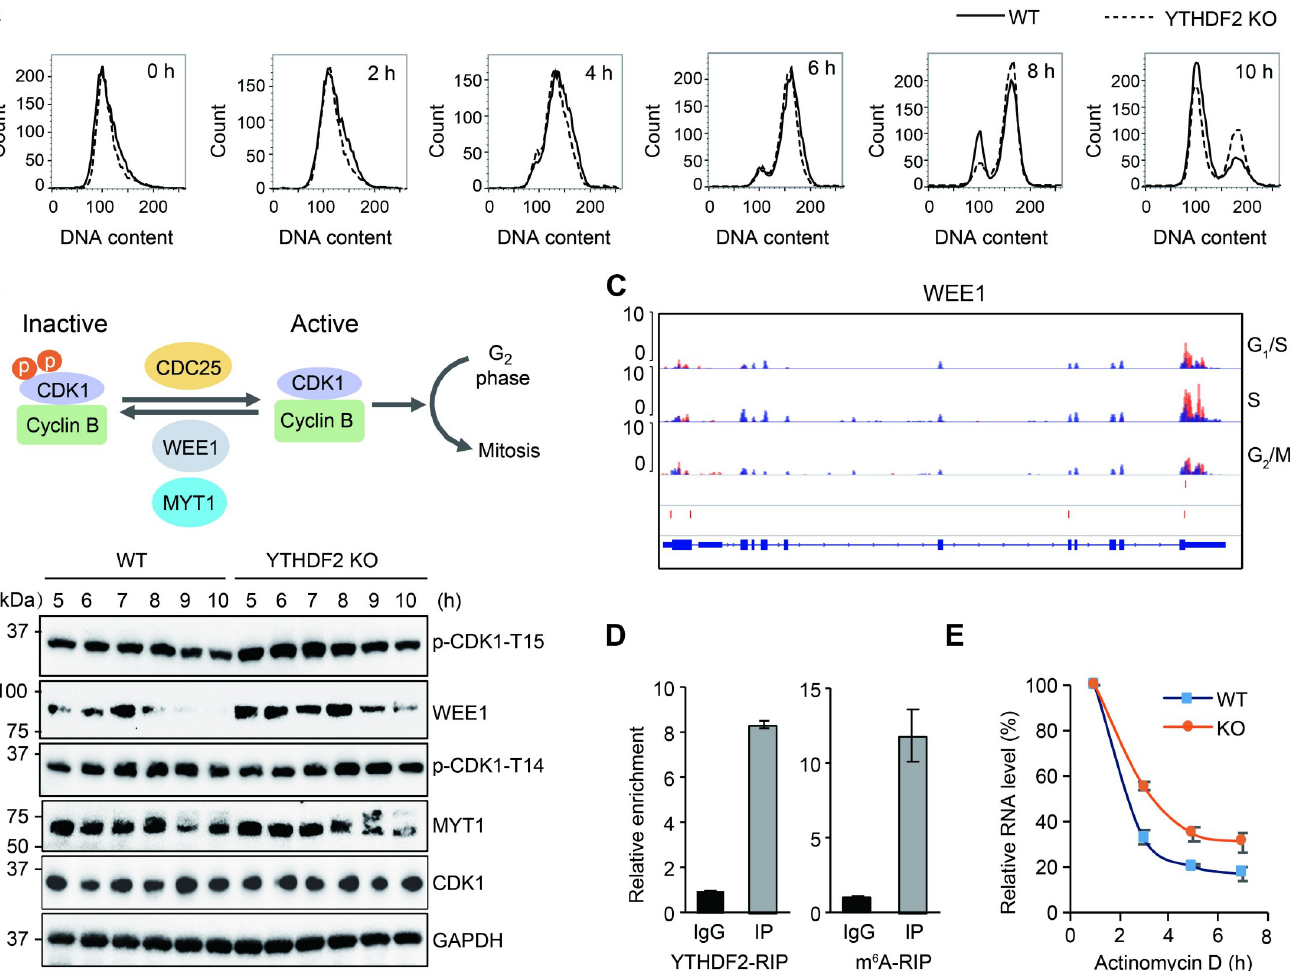
Fig 3. WEE1 is negatively regulated by YTHDF2. (A) Flow cytometry analysis of wild-type and YTHDF2 knockout cells that were synchronized and released from G 1 /S phase using double thymidine block. (B) Western blot analysis of key proteins that determine mitosis entry. The upper panel illustrates the key regulators of mitotic entry. The lower panel indicates western blot results from wild-type and YTHDF2 knockout samples that were synchronized to G 1 /S phase using double thymidine block. Samples were collected at times as indicated in the figure post release. (C) Genome browser view of WEE1 m 6 A peaks at different phases of the cell cycle. The red bars in lower 2 tracks represent the m 6 A sites identified by 2 replicates of YTHDF2 PAR-CLIP data [10]. (D) YTHDF2 and m 6 A RIP-qPCR for WEE1 . Rabbit IgG was used as control. (E) WEE1 mRNA decay assay using actinomycin D treatment. The relative levels of WEE1 transcripts were normalized to the housekeeping gene HPRT1 . Underlying data for this figure can be found in S1 Data. CDC25, cell division cycle 25; CDK1, cyclin-dependent kinase 1; GAPDH, glyceraldehyde 3-phosphate dehydrogenase; IgG, immunoglobulin G; IP, immunoprecipitation; KO, knockout; m 6 A, N 6 -methyladenosine; MYT1, membrane associated tyrosine/threonine 1; p-CDK1-T15, phosphorylating CDK1 at threonine 14; PAR-CLIP, photoactivatable ribonucleoside-enhanced crosslinking and immunoprecipitation; qPCR, quantitative PCR; RIP, RNA immunoprecipitation; WEE1, Wee1-like protein kinase; WT, wild type; YTHDF2, YTH N 6 - methyladenosine RNA binding protein 2.